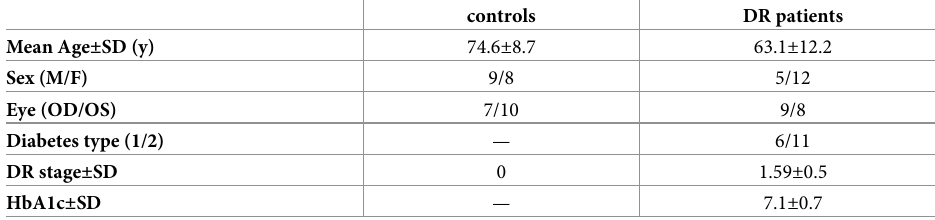
Table 1. Clinical patient data for both groups: Controls and diabetic retinopathy (DR) patients. Y = Year; M = male, F = female; OD = right eye; OS = left eye. DR stages are: 1 = mild to moderate NPDR, 2 = severe NPDR, and 3 =